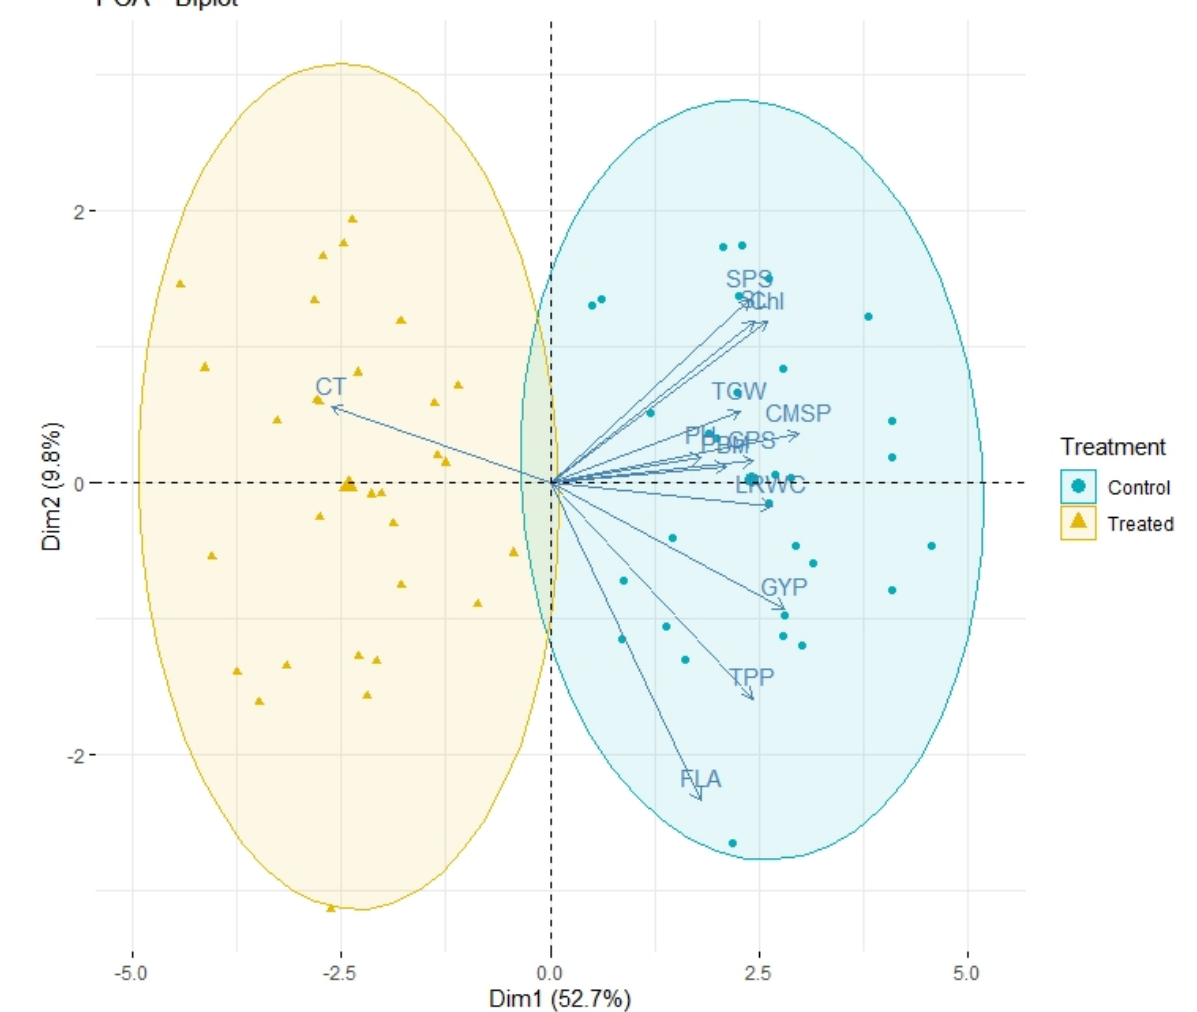
Figure 2. PCA scatter diagram illustrating the extent of similarity and dissimilarity in the expression of physiological, growth and yield traits of wheat genotypes under control and stress treatment conditions. Chl, chlorophyll; CT, canopy temperature; CMPS, cell membrane percentage stability; LRWC, leaf relative water content; FLA, flag leaf area; PH, plant height; TPP, tillersplant − 1 ; SL, spike length; SPS, spikelets spike − 1 ; GPS, grains spike − 1 ; GYP, grain yield spike − 1 ; TGW, thousand grain weight; PBM, plant biomass.